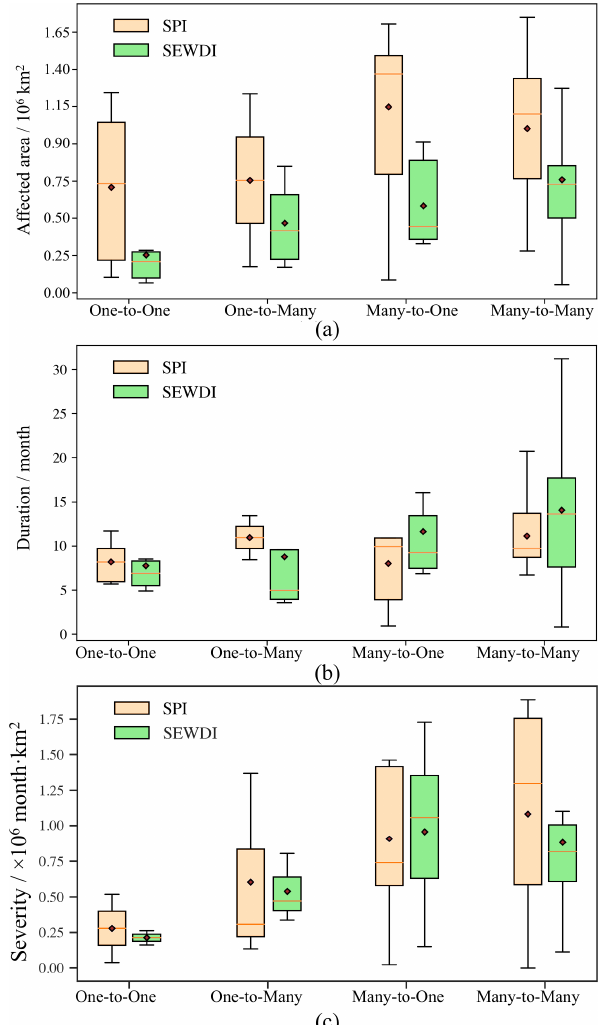
Figure 5. A box plot showing the intensity, duration, and affected area of paired meteorological–ecological drought among different types.